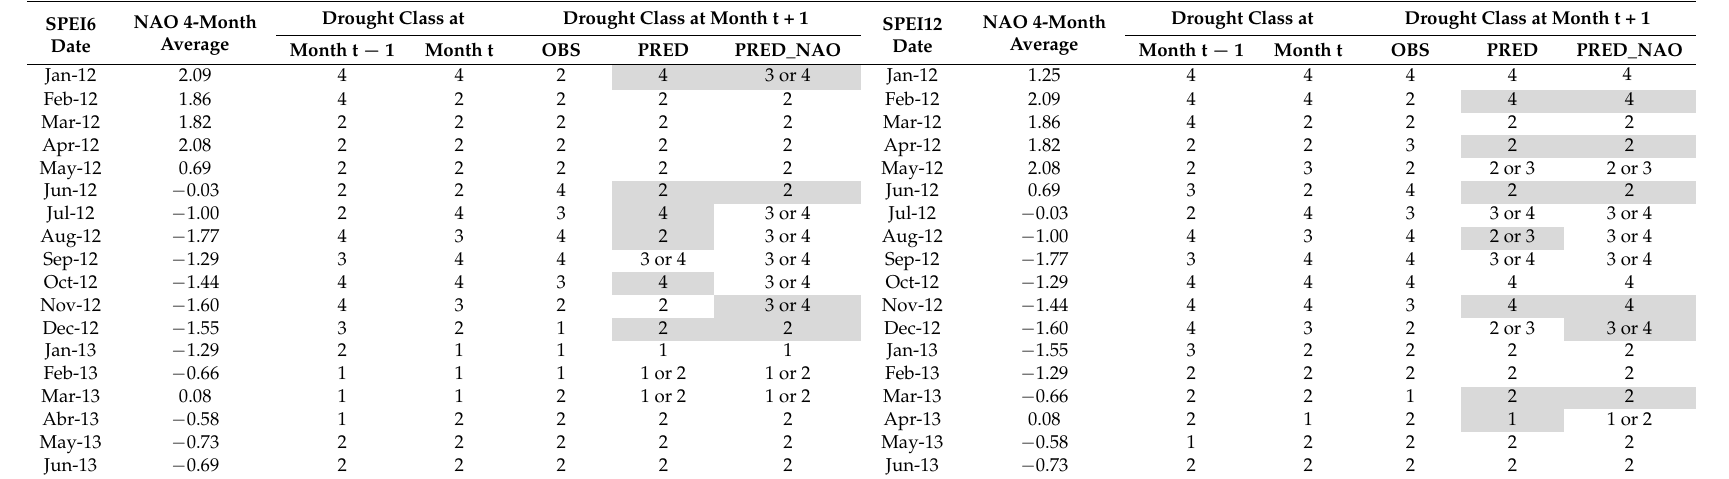
Table 6. The SPEI6 and SPEI12: Comparison between observed (OBS) and predicted drought class transitions (with and without the NAO influence, “PRED” and “PRED_NAO”, respectively) for grid point 13 (Table 3) during the period from January 2012 to June 2013.